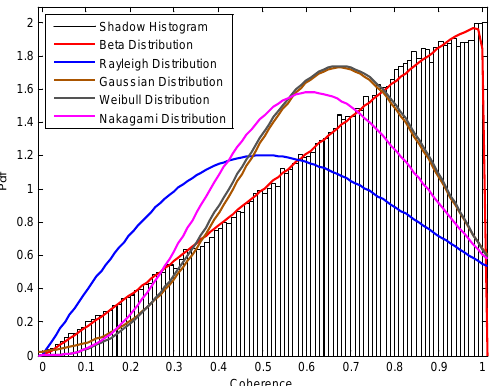
Figure 5. The performances of different statistical models for shadow.